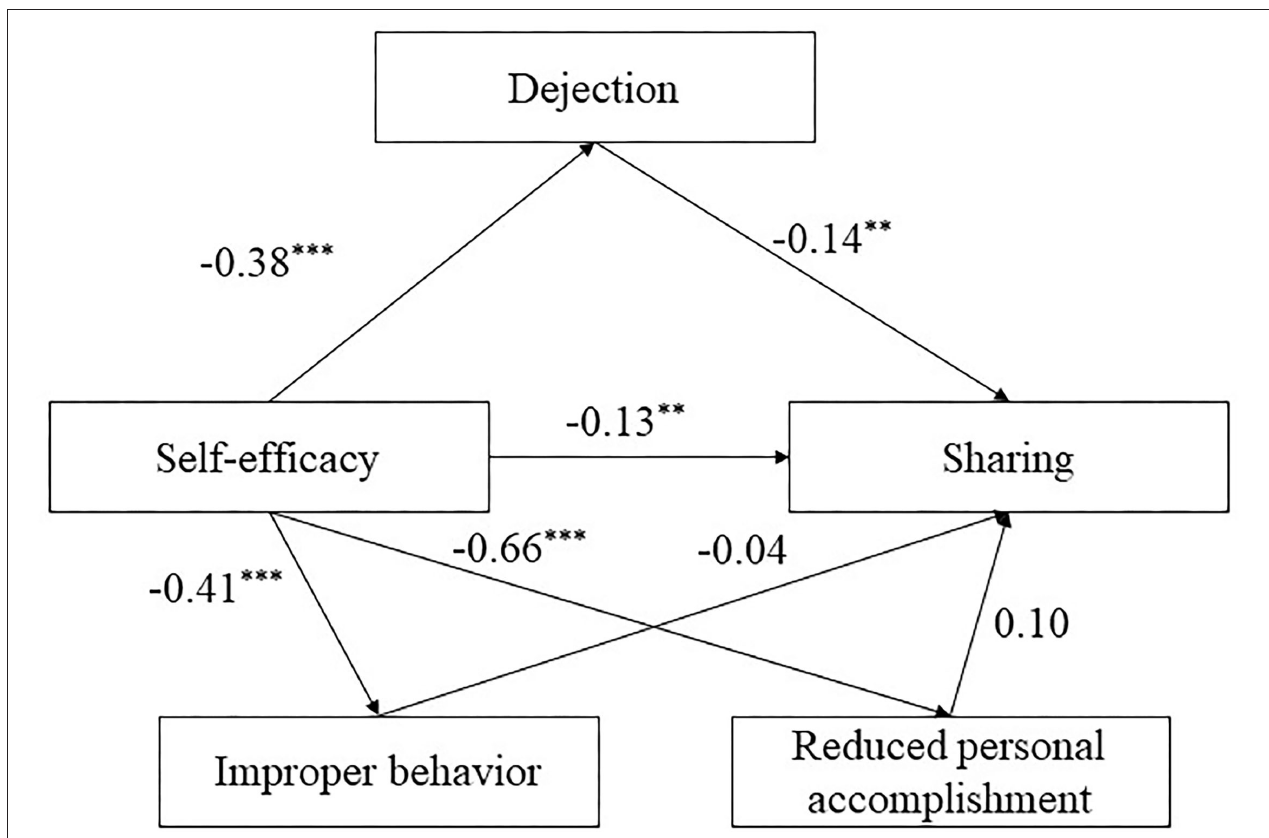
FIGURE 3 | The structural model of self-efficacy, dejection, reduced personal accomplishment and improper behavior on sharing. Significant paths are presented by asterisks (** p < 0.01, *** p < 0.001).